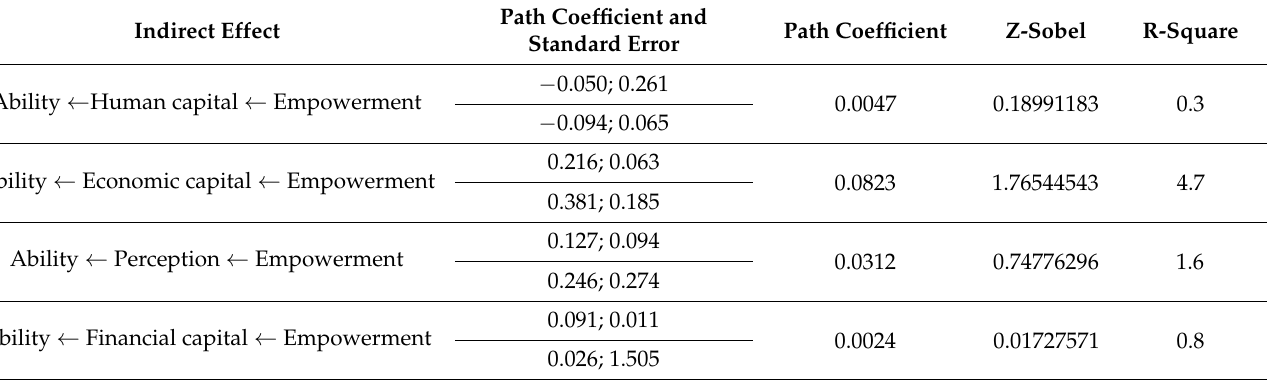
Table 10. Indirect effect path analysis test